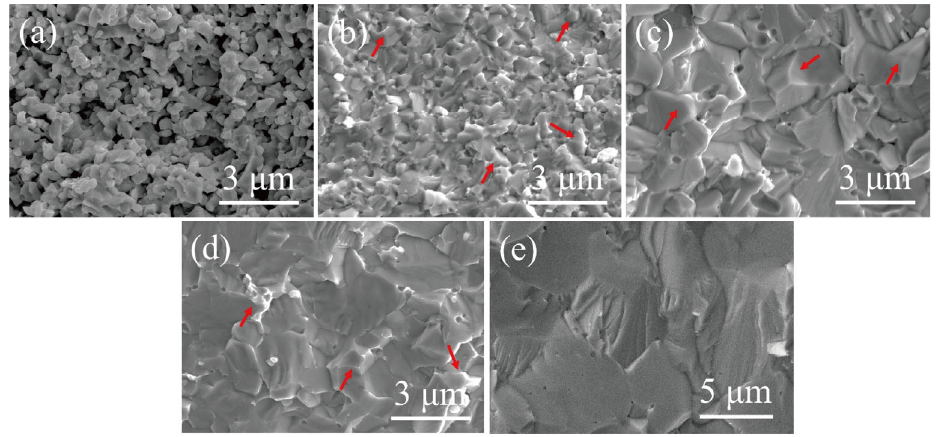
Fig. 4 SEM images of the fracture surfaces for the as-sintered specimens: (a) HC1350-L, (b) HC1350-H, (c) HC1550-L, (d) HC1550-H, and (e) H2000. Red arrows show the grains exhibiting an intergranular fracture